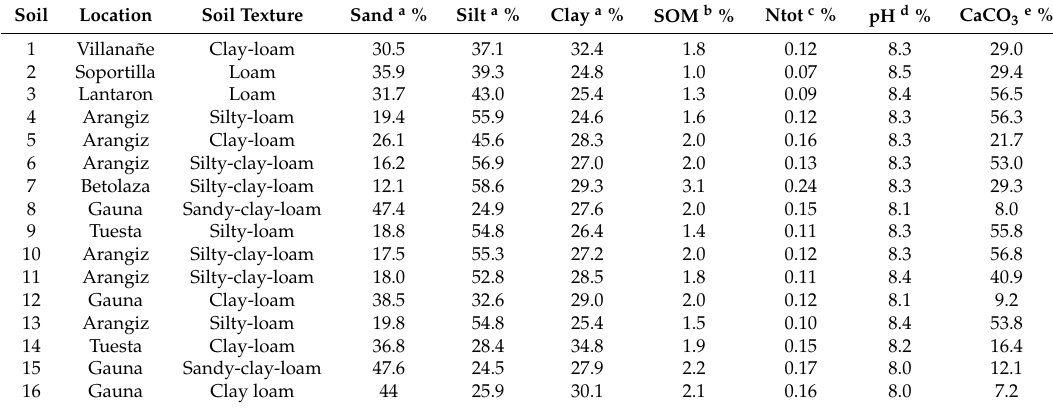
Table 1. Location, and physical and chemical characteristics, of the soils from Araba (Basque Country, northern Spain) used in the greenhouse